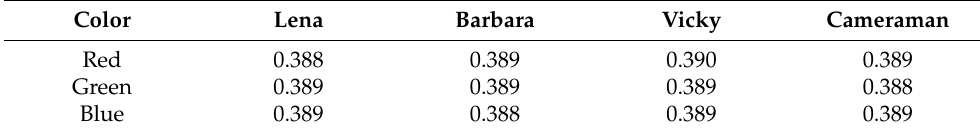
Table 10. Homogeneity of Figure 1 images after encryption.